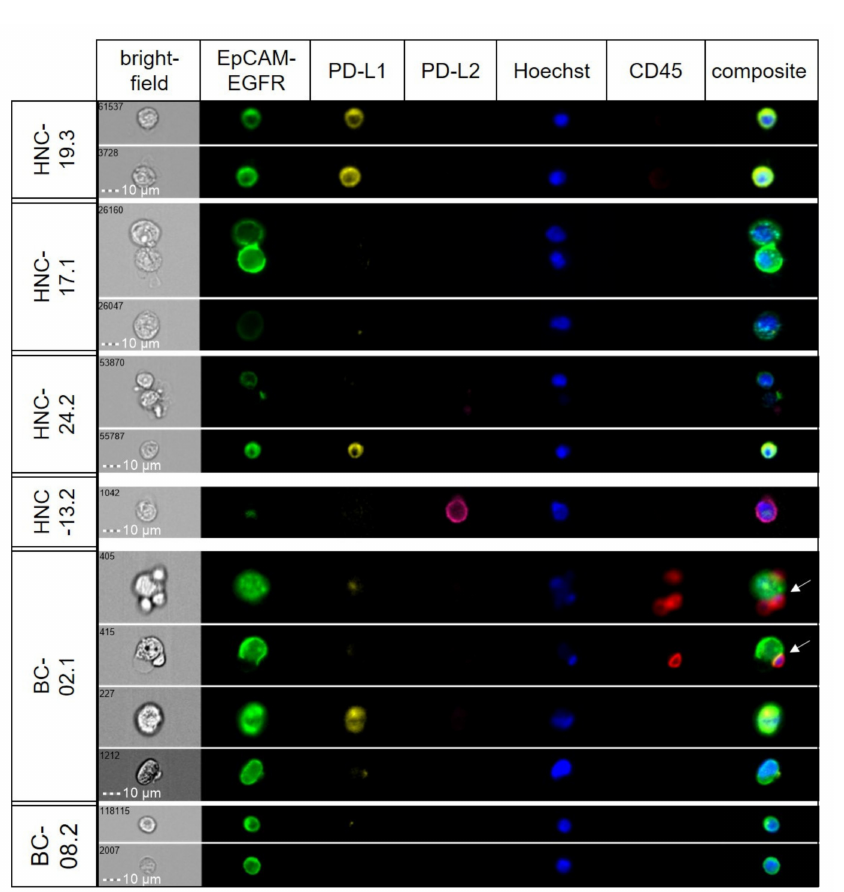
Figure 4. Detection of intratumoral heterogeneity in marker expression in CTCs . Representative images from selected patient samples (head and neck; HNC), showing varying expression levels of target proteins. In one case (BC–02.1), clusters of CTCs and leukocytes were observed (white arrows).